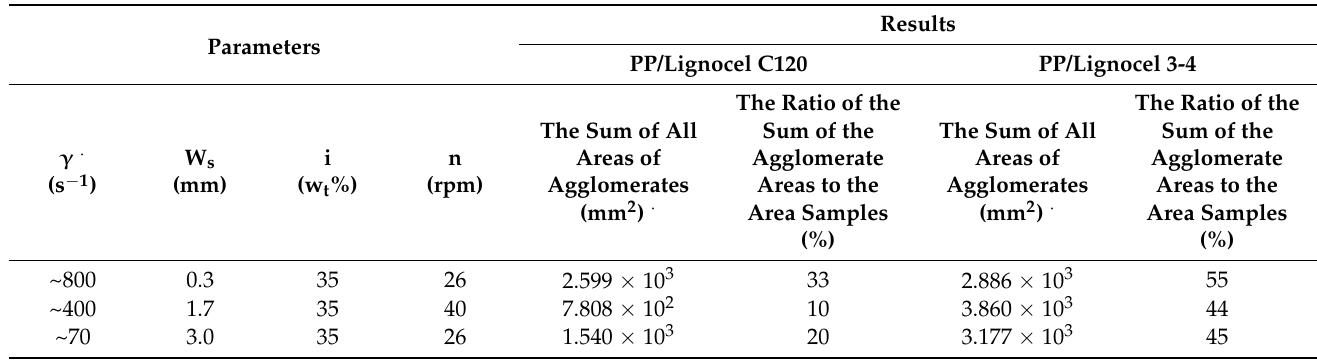
Table 3. Results of the analysis of WPC composite images for different values of shear rate.